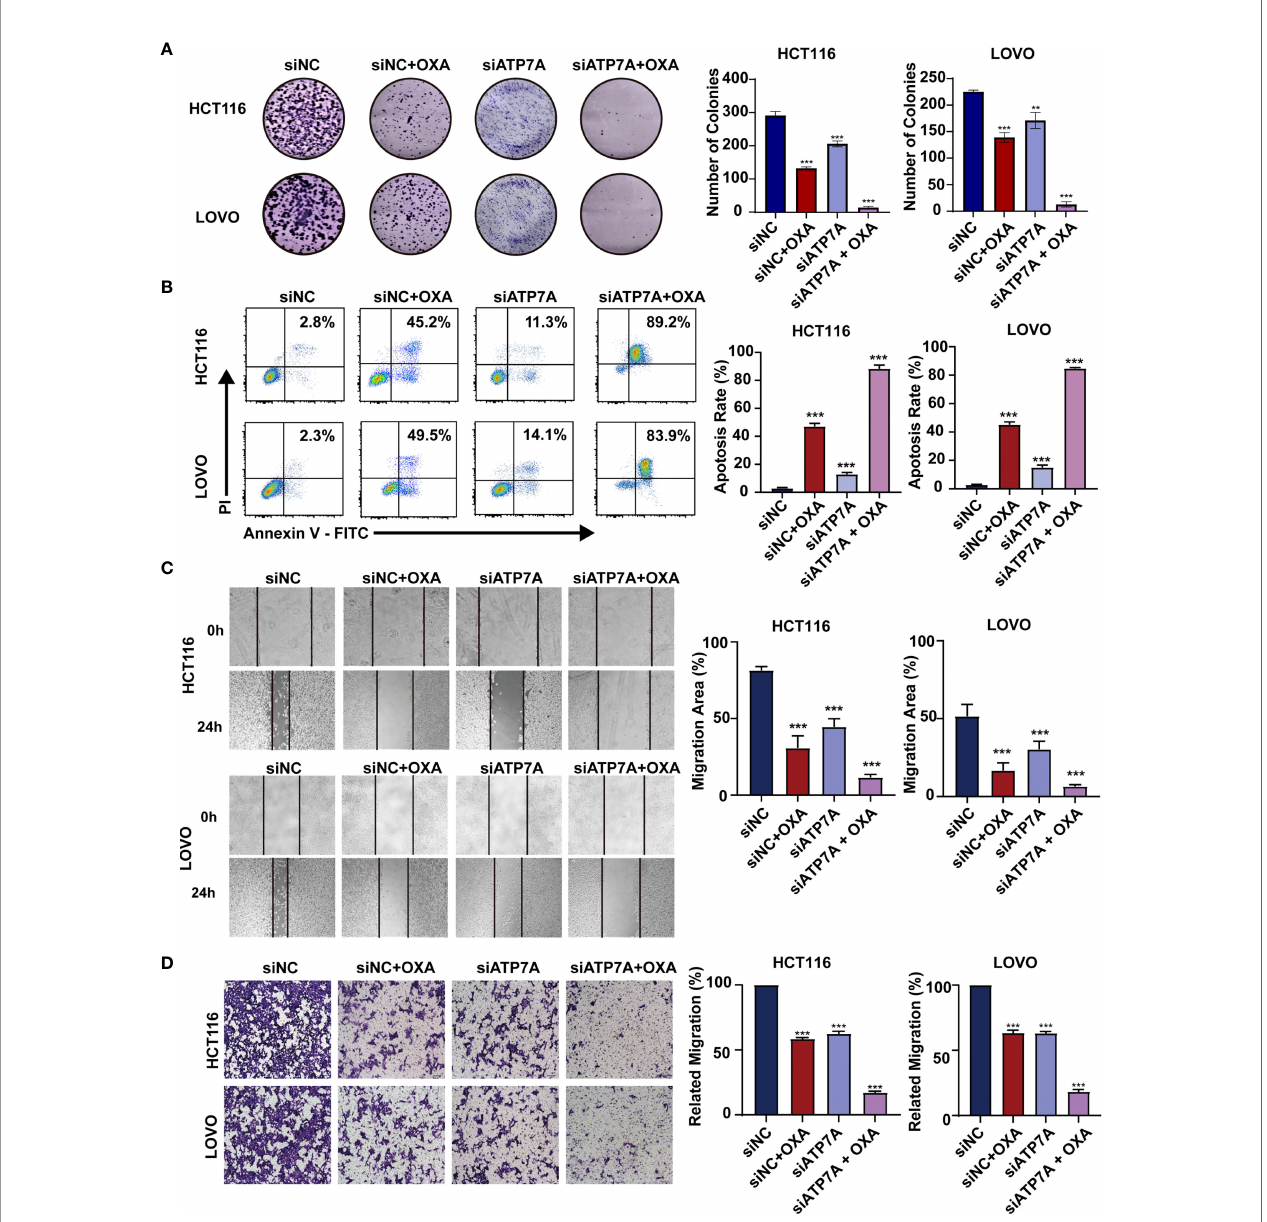
FIGURE 3 | Knockdown of ATP7A expression may inhibit cancer tumorigenesis in vitro . (A) Colony formation assays in HCT116 and LOVO cells. (B) A fl ow cytometer was performed to assess the apoptosis rate of HCT116 and LOVO cells. (C) Wound healing assay of HCT116 and LOVO cells. (D) Transwell assay was performed to evaluate the invasion of HCT116 and LOVO cells. *P < 0.05; **P < 0.01 and ***P < 0.001 when compared to the control